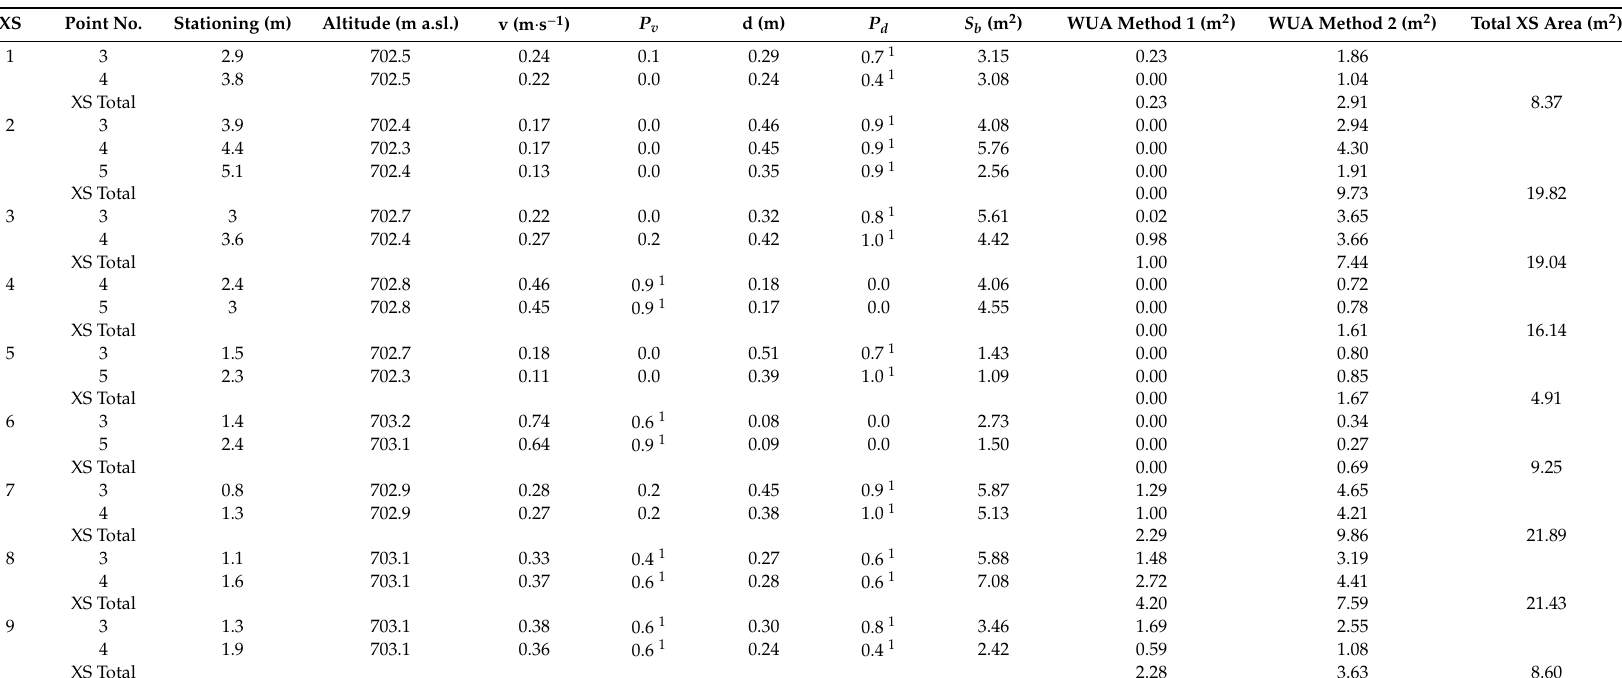
Table 1. Comparison of the flow velocity and water depth parameters of the Teplica River at the flow rate that was measured during the field survey. XS—cross-sections from Figure 4, Point No.—points in cross-sections (only points where the value of the water depth or flow velocity parameters were greater than 0.4 are selected), Stationing—upstream stationing of the XS, Altitude—altitude of the riverbed bottom at a given point, v—flow velocity in point, P v —velocity parameter, d—water depth in point, P d —depth parameter, S b —cell surface from Equation (1), weighted usable area (WUA) Method 1—WUA according to Equation (2), WUA Method 2—WUA according to Equation (4), and Total XS Area—total cross-section area.